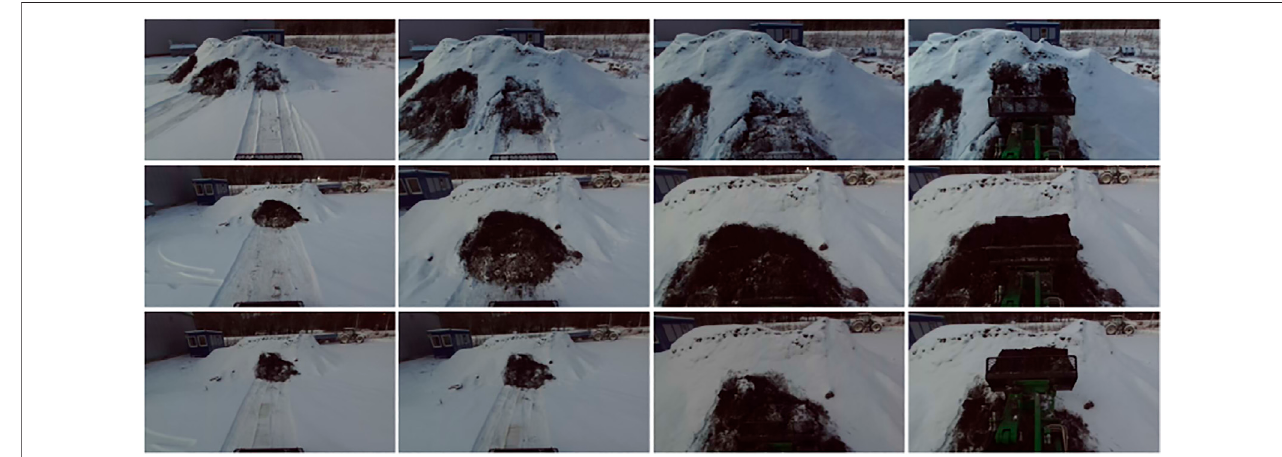
FIGURE 7 | Examples of images from D winter .